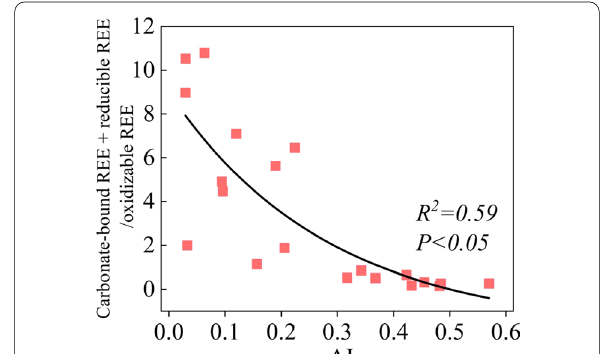
Fig. 6 The correlation of the ratios of the sum of carbonate‑bound and reducible REE content to oxidizable REE content (unless) against aridity index (AI) ( R 2 0.59 , P < =